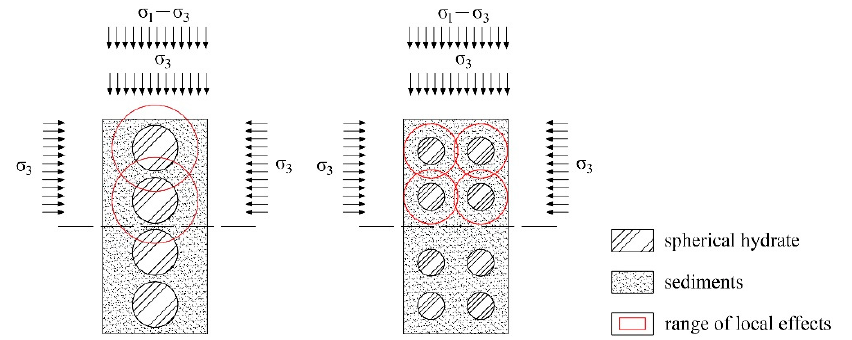
Figure 9. Triaxial stress–strain curves of sediments containing spherical hydrates ( 𝑟 = 8.5 𝑚𝑚 ).